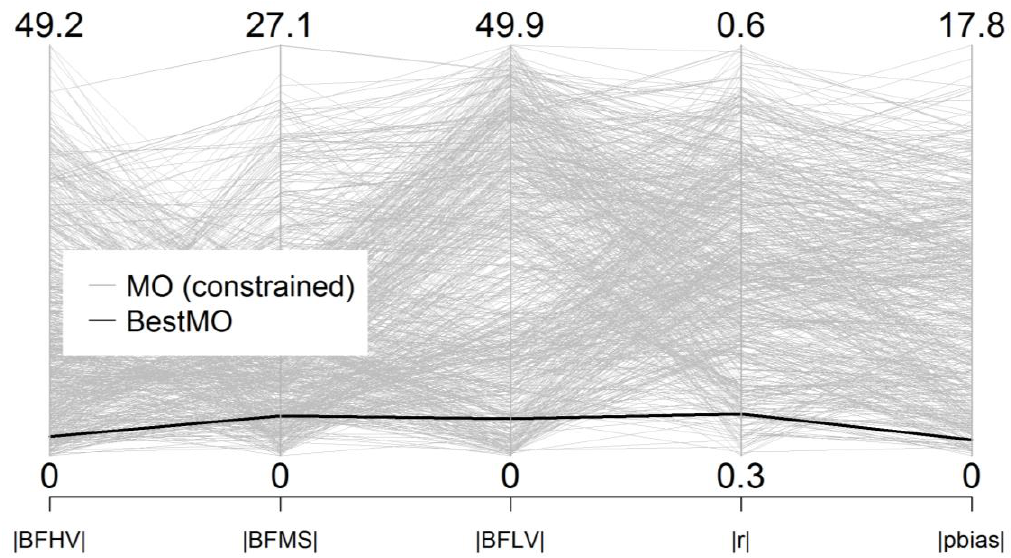
Figure 8. The trade-off in evaluation criteria in a constrained search using the Borg MOEA for sub-basins 1–18 based on streamflow signatures and remote sensing-based evapotranspiration during the calibration period (2002–2007). The location where the line intersects each vertical axis designates the relative objective value. The gray lines represent the efficiency measures in the provided parameter space (MO (constrained)), while the solid black line represents the selected best trade-off (BestMO) from the Pareto solution set. Note that the correlation coefficient is defined as 1 − r.